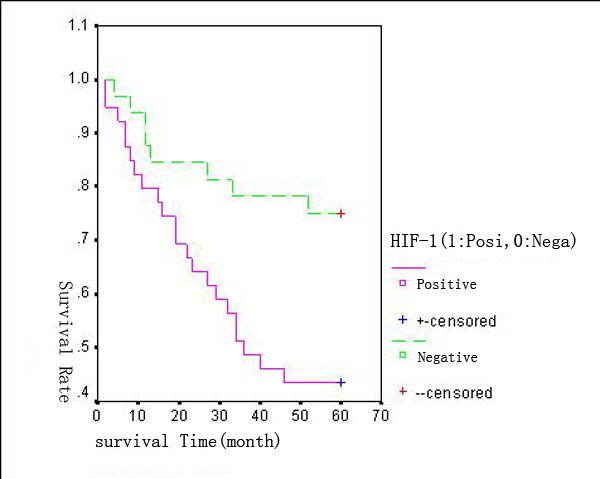
Kaplan--Meier overall survival (OS) curves for 71 patients with colorectal cancer. Patients with HIF-1α positive expression had a significantly worse OS compared with those with HIF-1α negative expression.